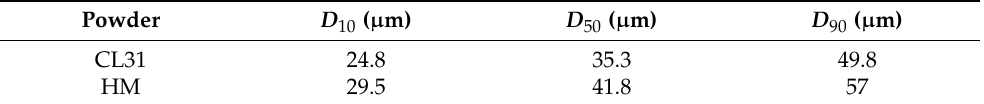
Figure 3. PSD Volume of the CL31 and HM powders. ( a ) relative PSD frequency and ( b ) cumulative PSD frequency. Table 3. Particle size percentile values of the powders, derived from the cumulative volume curves.